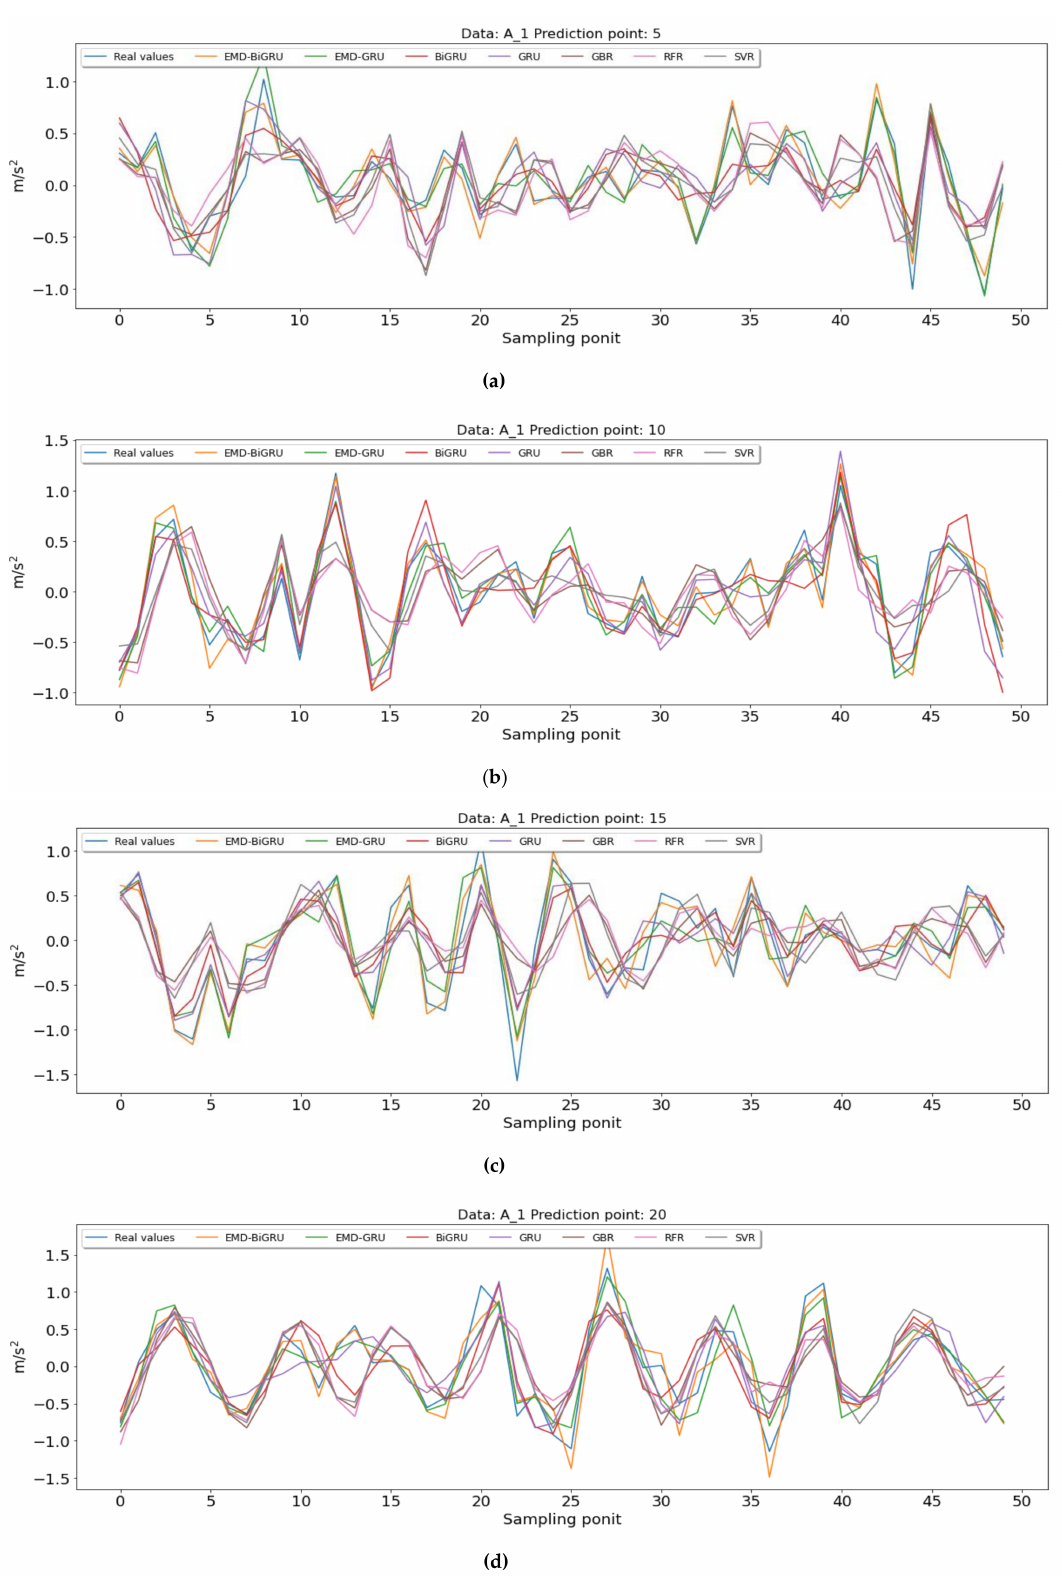
Figure 14. Comparisons results for different data sets using various algorithms. ( a ) Comparisons of predicted results for the A_1 data set using different algorithms (points 5). ( b ) Comparisons of predicted results for the A_1 data set using different algorithms (points 10). ( c ) Comparisons of predicted results for the A_1 data set using different algorithms (points 15). ( d ) Comparisons of predicted results for the A_1 data set using different algorithms (points